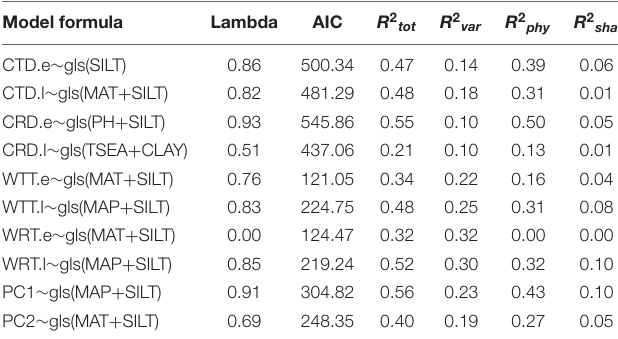
TABLE 2 | The most parsimonious PGLS models of xylem characters as functions of environmental indices with models’ R 2 partitioned. Model